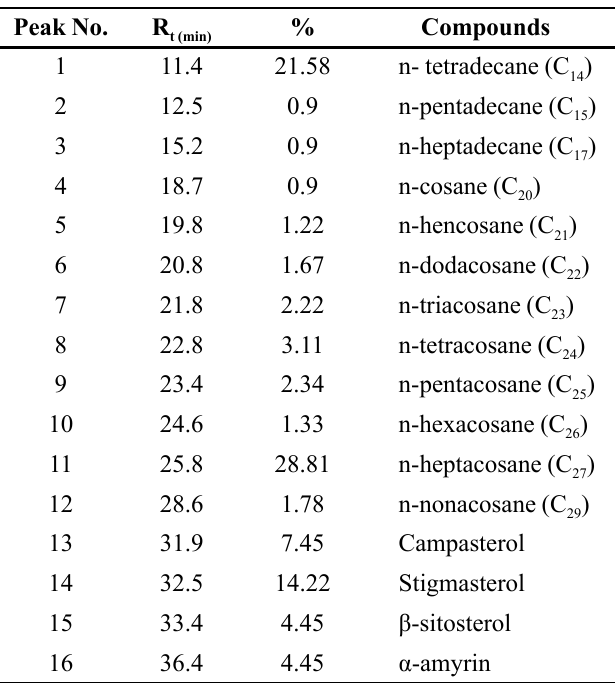
TABLE III - GLC analysis of the unsaponifiable fraction of Phyllanthus atropurpureus Peak